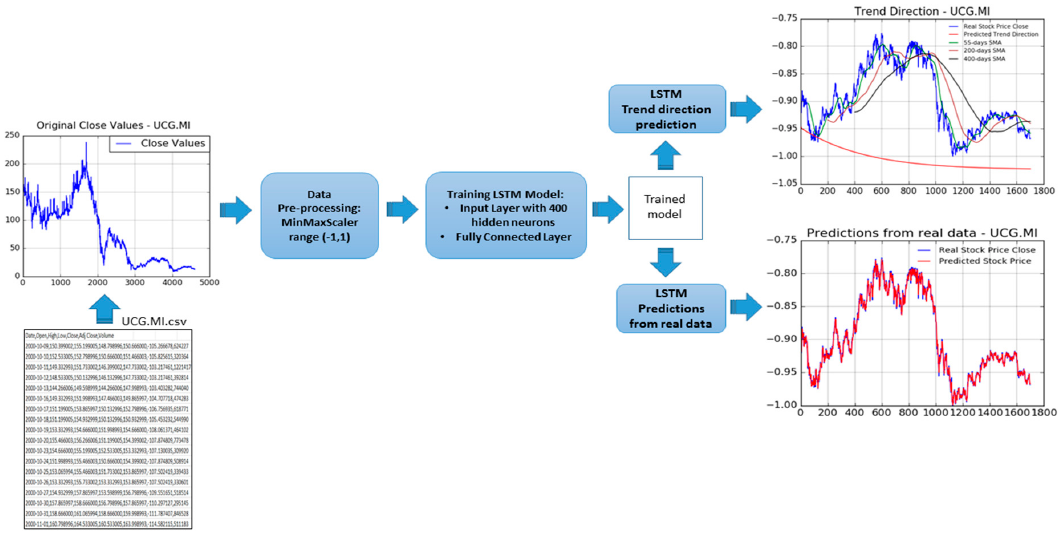
Figure 4. Overall scheme for the proposed stock trend/price prediction pipeline.